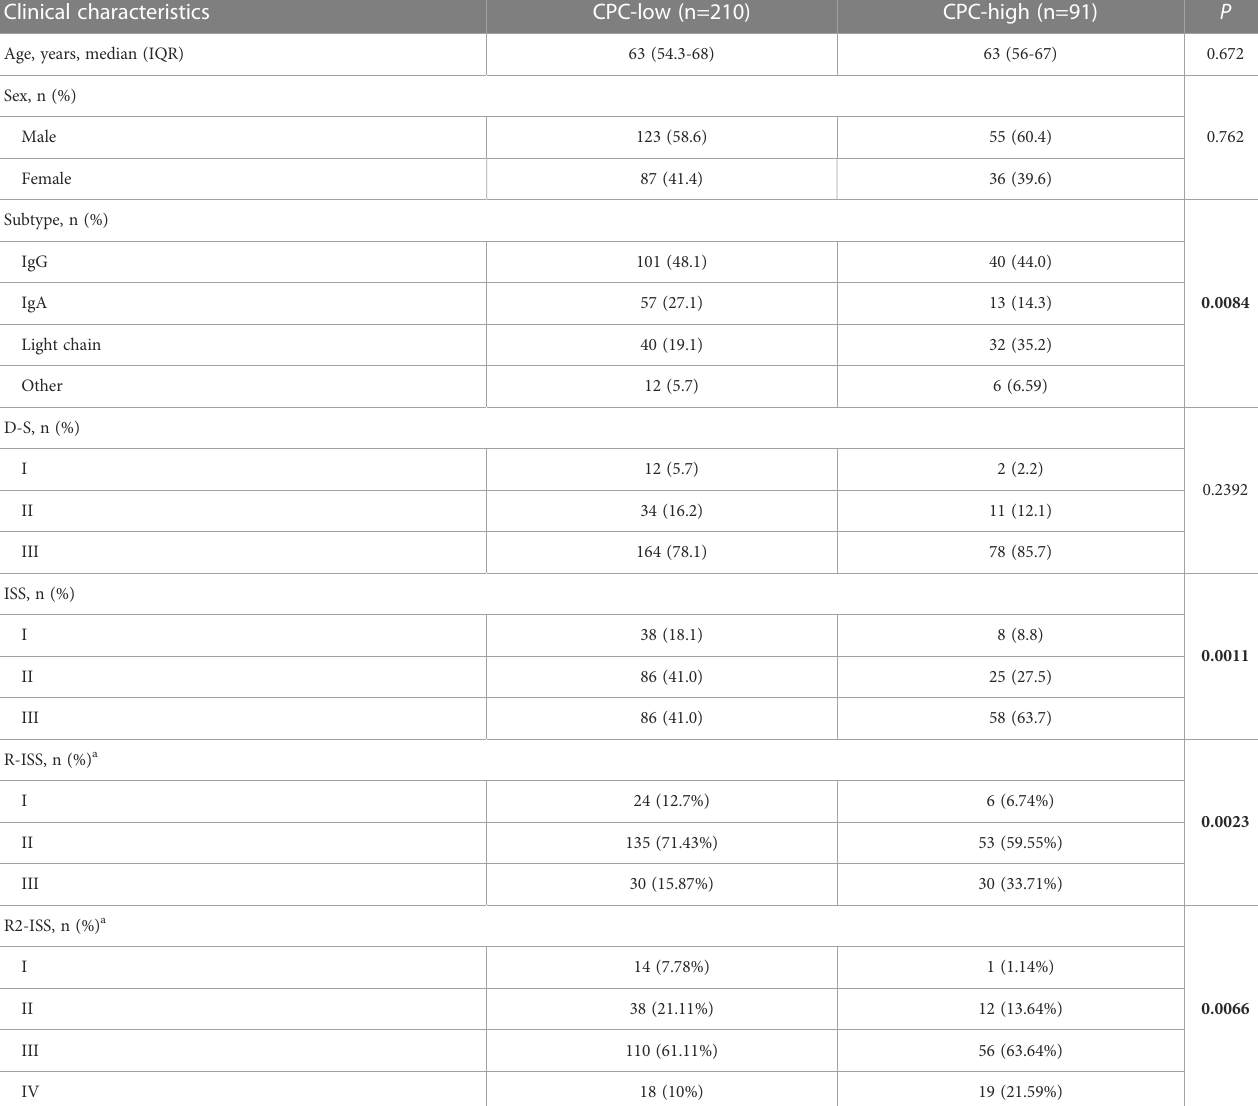
TABLE 1 Clinical characteristics of patients according to quanti fi cation of CPC. Clinical